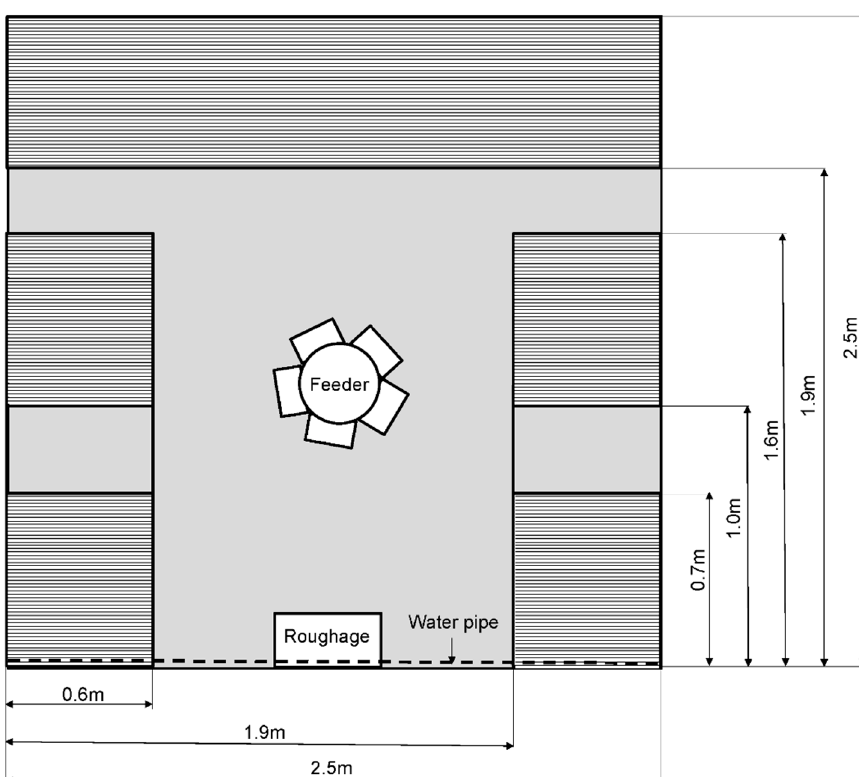
Figure 1. Schematic drawing of a pen seen from above. Ground floor depicted in grey, with elevated platforms depicted as striped. The ground floor consisted either of concrete littered with straw (Straw pens) or of slatted plastic panels (Slat pens).